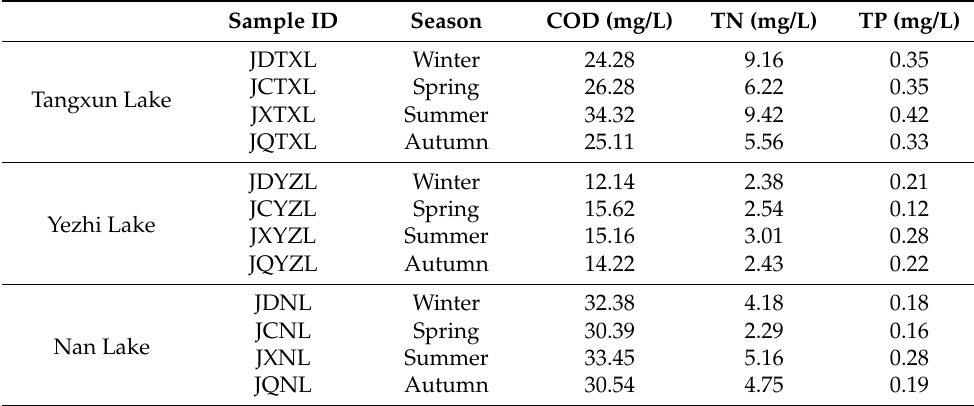
Table 2. The seasonal α -diversity indices of the bacterial community of the three lakes.